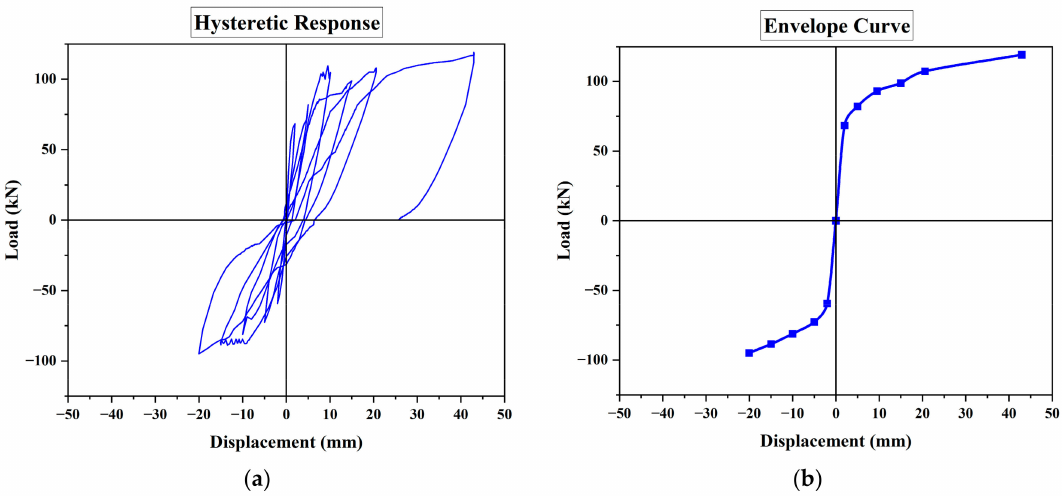
Figure 9. Experimental results of GPC-CM ( a ) Hysteretic response ( b ) Envelope curve. As with bare frame structures, GPC confined masonry has also shown a good match of seismic characteristics with the traditional concrete wall. The initial stiffness of the GPC wall specimen was estimated 45.2% higher than that of OPC wall masonry, whereas wall shear stress was calculated as 1.5% greater in OPC-CM. As far as peak lateral load is